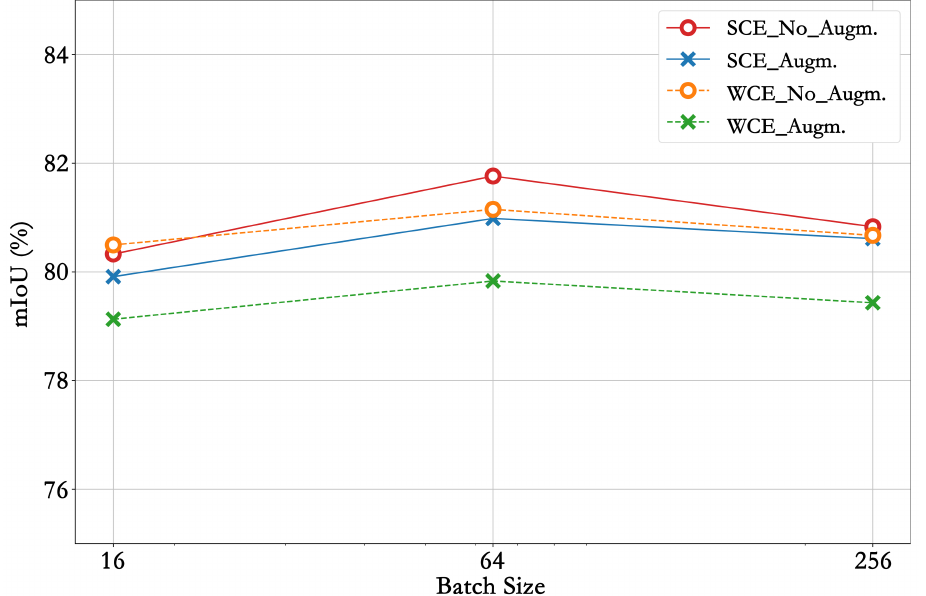
Figure 7. mIoU values of the experiments performed with different losses, i.e., soft cross entropy (SCE) and weighted cross entropy (WCE); application or not of data augmentations and various batch sizes (16, 64, 256). Table 6. Ablation study about training loss. We can observe how the WCE performs better on the unbalanced classes, i.e., cars and low vegetation, w.r.t. the SCE, but worse on the other ones. Method